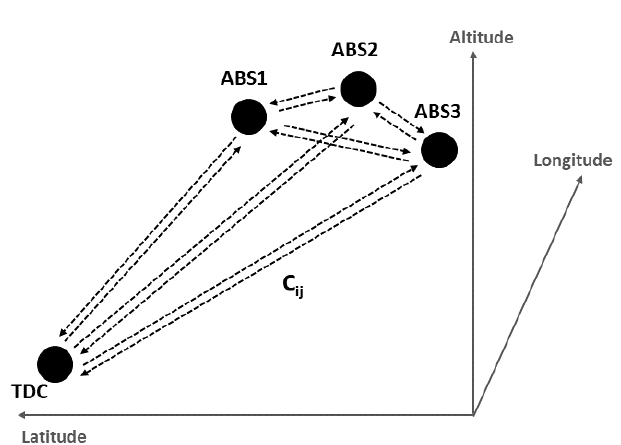
Figure 2. Corresponding topology graph for the